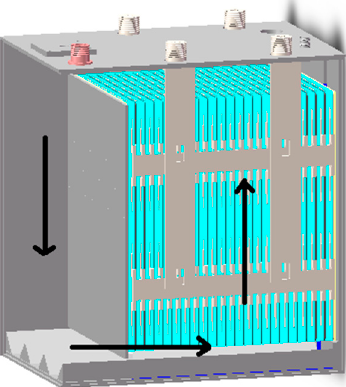
Figure 1. Basic structure of zinc–nickel single-flow battery.